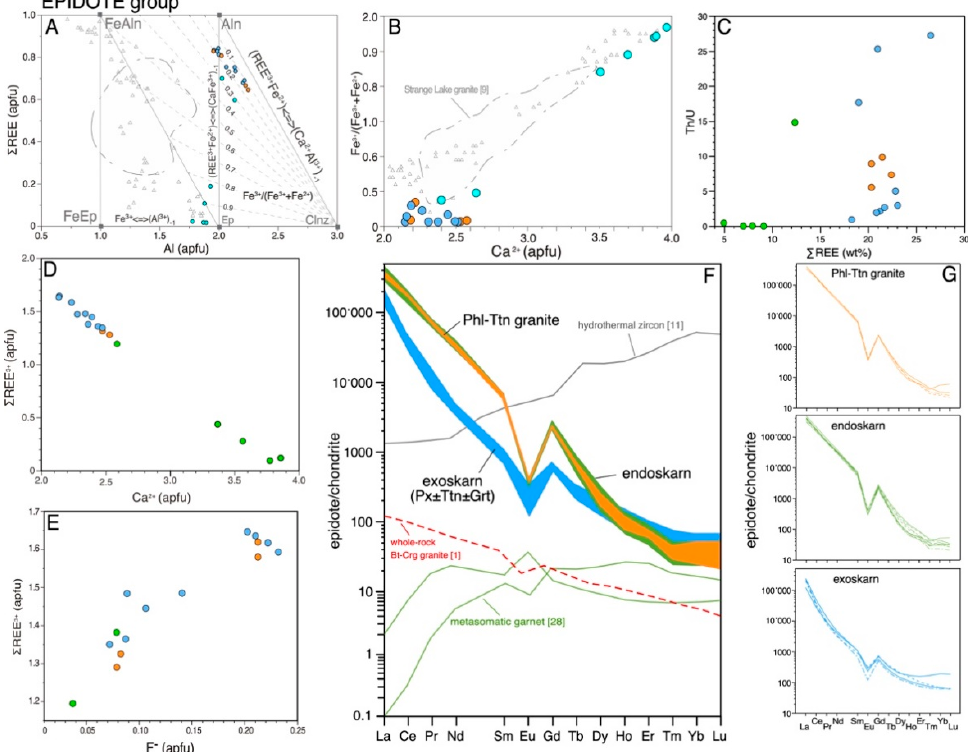
Figure 12. Mineral chemistry of metasomatic epidote group minerals from the granite and the exoskarn bodies. Color of dots and lines refer to same samples (see Figure 8F). ( A ) Diagram showing the possible element substitution mechanisms in the epidote group minerals, along with the classification scheme of [32] based on the Fe 3+ /(Fe 3+ + Fe 2+ ) ratio. ( B ) Ca vs. Fe 3+ /(Fe 3+ + Fe 2+ ) diagram, with allanite showing the lowest Fe 3+ /(Fe 3+ + Fe 2+ ) ratios. For comparison, data for epidote group minerals from the Corupá pluton [33] and Strange Lake granite [11] are also shown. ( C – E ) Mineral chemistry of metasomatic epidote and allanite showing a correlation between REE, the Th/U ratio, and the F content. ( F ) Chondrite ‐ normalized REE pattern for allanite from phlogopite ‐ titanite granite, endoskarn, and exoskarn bodies. ( G ) On the right a detailed chondrite ‐ normalized REE pattern for allanite from each lithology are reported. For comparison, whole ‐ rock (WR) data from reference [1]. Chondrite normalization values are taken from reference [25]. Table 5. Electron microprobe and LA ‐ ICP ‐ MS analyses for vesuvianite and epidote ‐ group crystals from the BM mine.